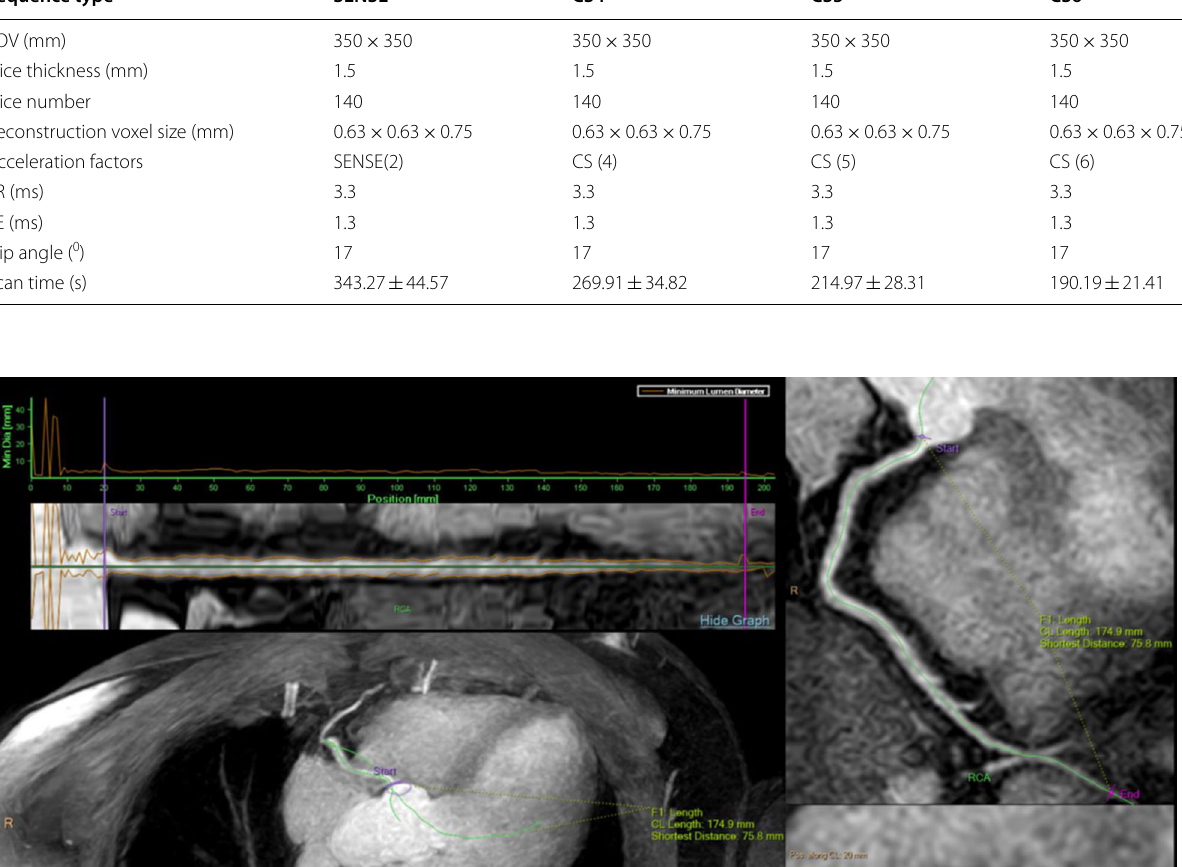
Table 1 Image parameters of the 4 sequences of NCMRA Sequence type